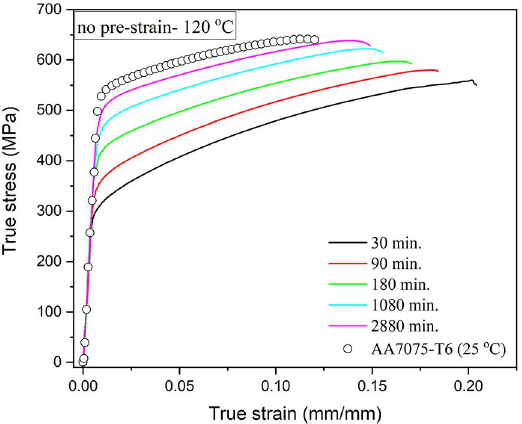
Figure 9. True stress vs. true strain for different aging time at 120 ºC (no pre-strain)